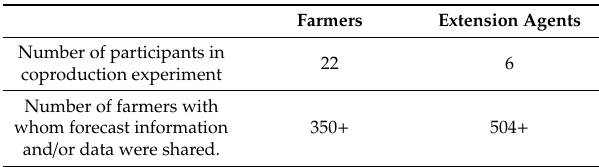
Table 3. Numbers of farmers reached indirectly, via participants in the coproduction experiment (both farmers and extension agents). Number of farmers with whom forecast information and/or data were shared.